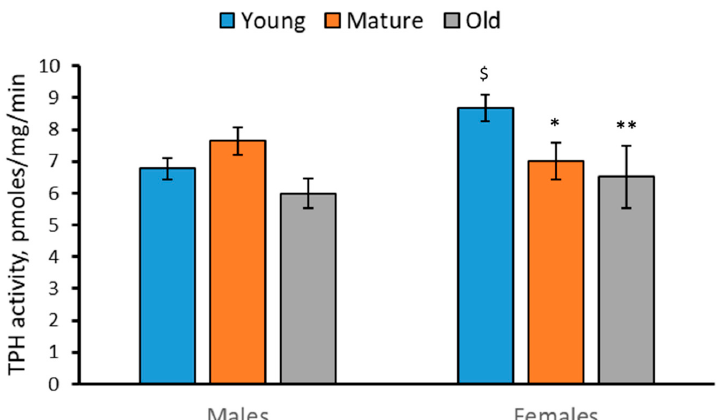
Figure 3. TPH activity in the brain of 2 (young)-, 4 (mature)- and 7 (old)-month-old male and female N. furzeri . * p < 0.05, ** p < 0.01 vs. young females; $ p < 0.05 vs. young males. 2.4. Activity of MAO in the Brain of 2-, 4- and 7-Month-Old Males and Females of N. furzeri Marked effect of the “Age” factor (F(2,42) = 6.24, p = 0.004), but not of the “Sex” factor (F(2,42) < 1), and the factor interaction (F(2,42) < 1) on the MAO activity in the brain of N. furzeri was found. The MAO activity increased in the brain of old females compared to young and mature females (Figure 4).